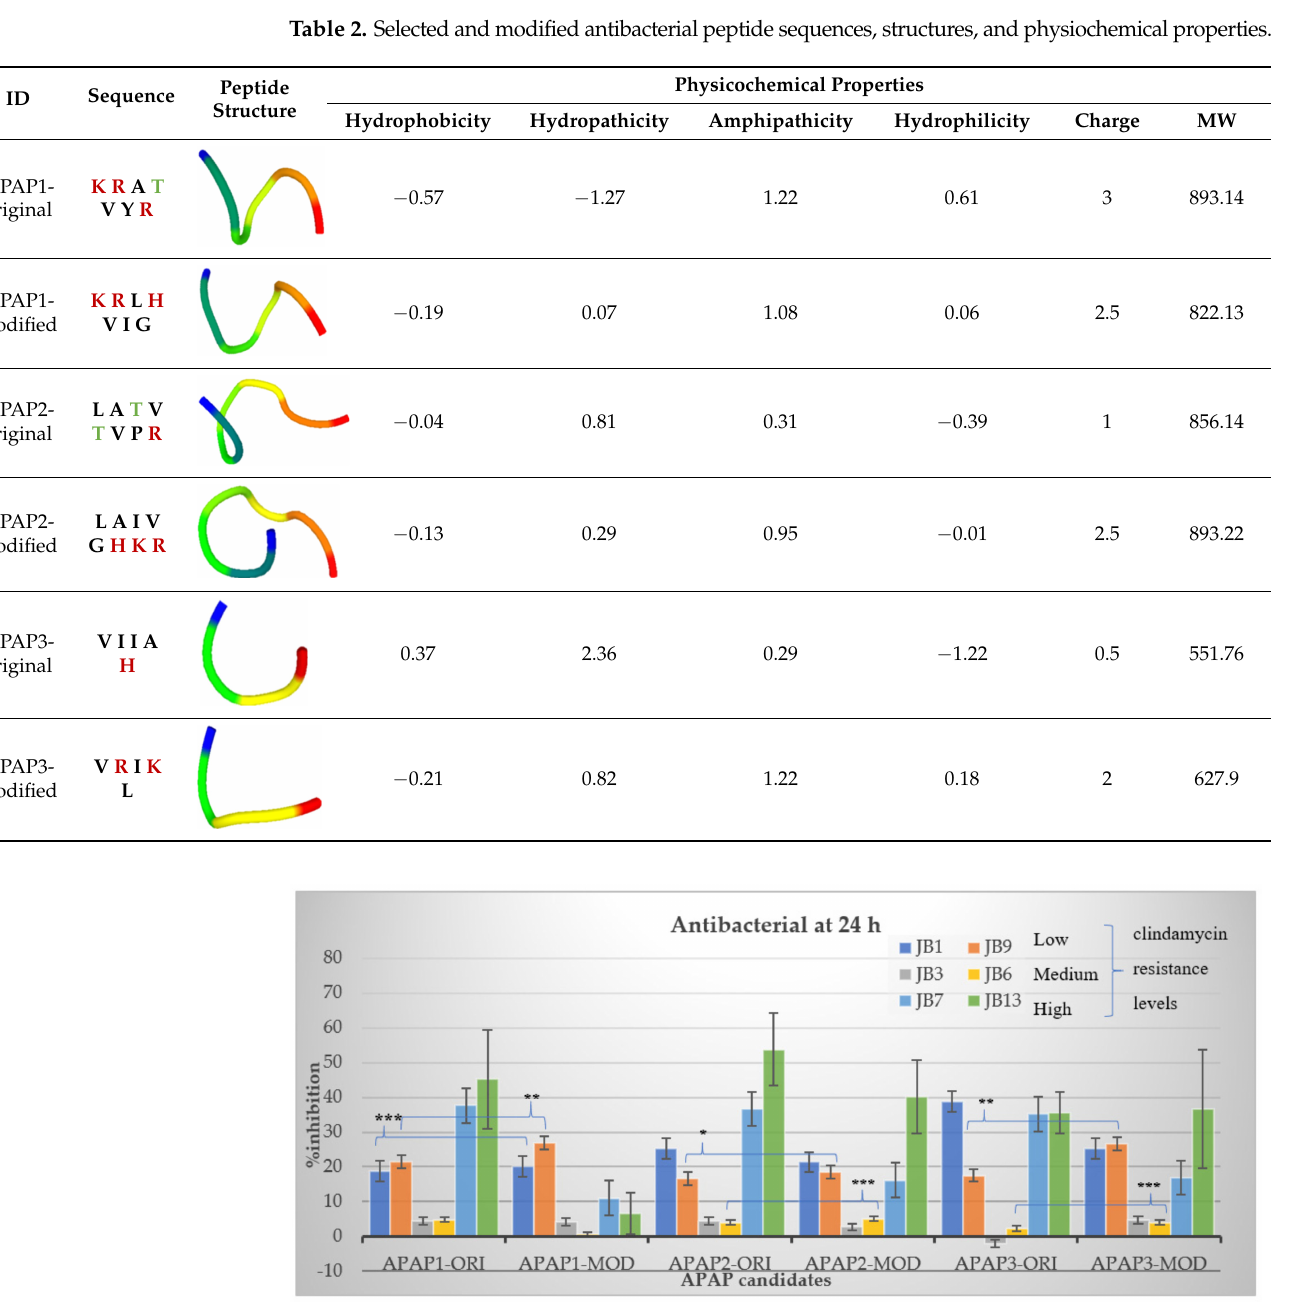
Figure 2. Inhibition percentage of P. acnes isolates treated with APAP-original and APAP-modified biomimetic peptides. Each biomimetic APAP candidate (20 µ g/mL) was tested against six isolates of P. acnes in biological triplicates. Bars indicated significant difference at p < 0.001 (***), p < 0.005 (**) and p < 0.05 (*). Error bars represented standard error of the